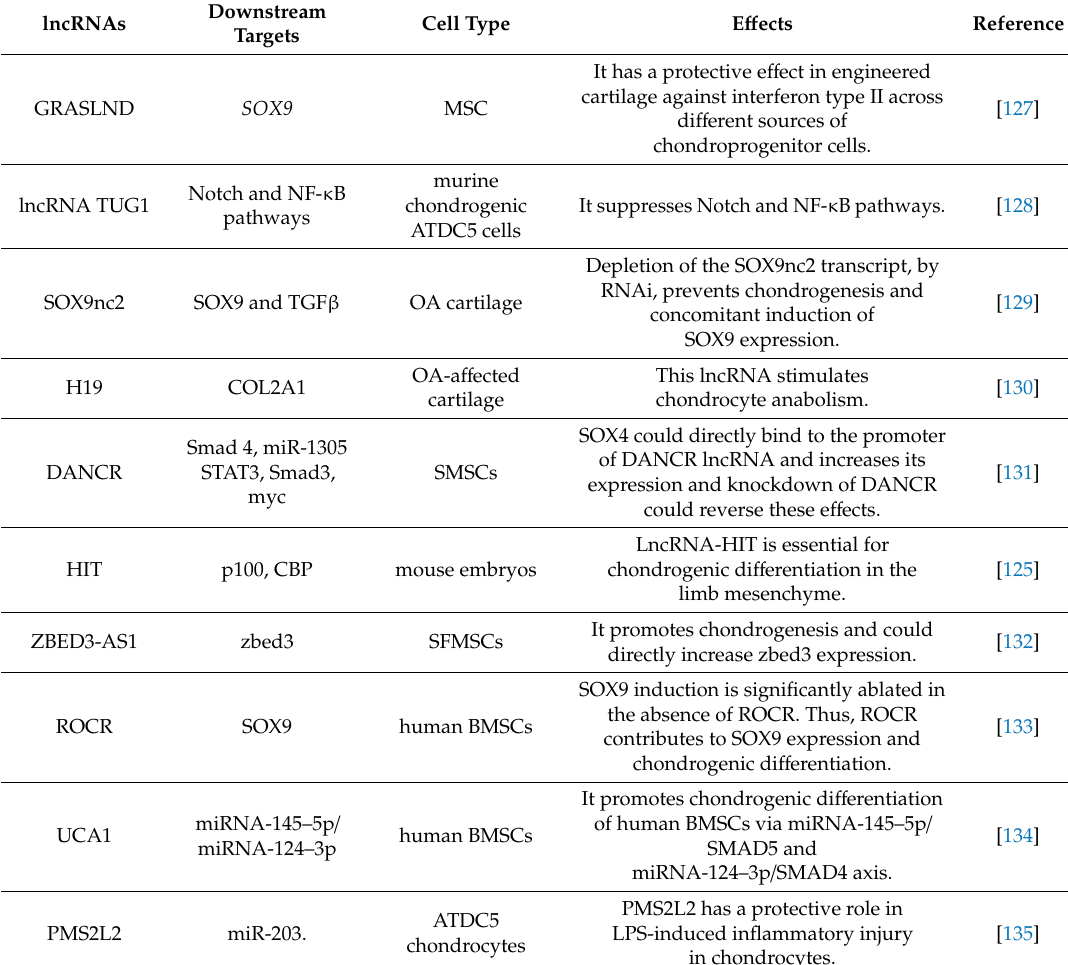
Table 2. Summary of lncRNAs and their roles in